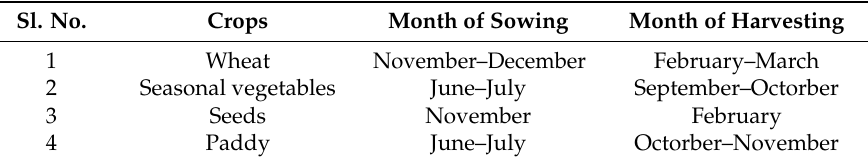
Figure 5. Seasonal and annual actual evapotranspiration (ET in mm) for 2009, 2010, and 2011. Table 2. Sowing and harvesting season of